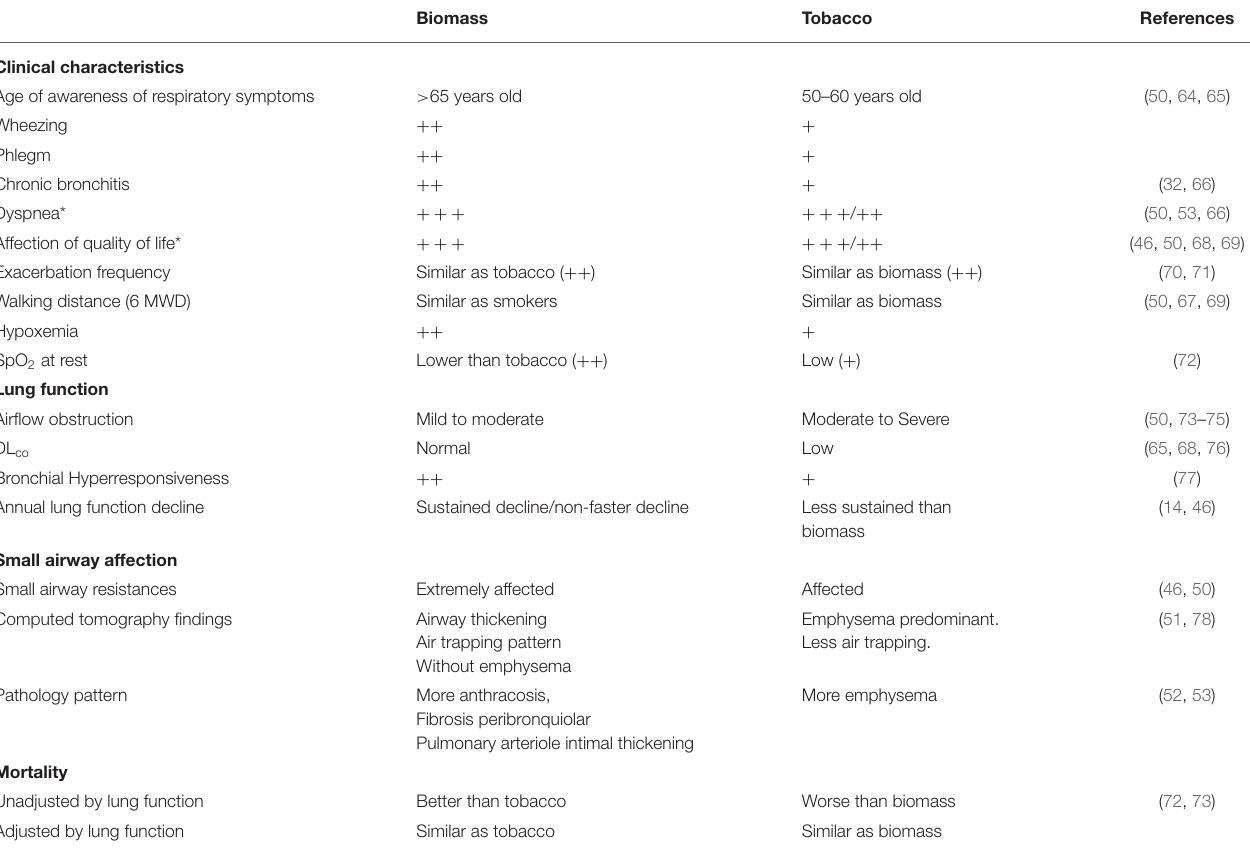
TABLE 1 | COPD characteristics of subjects exposed to biomass and tobacco